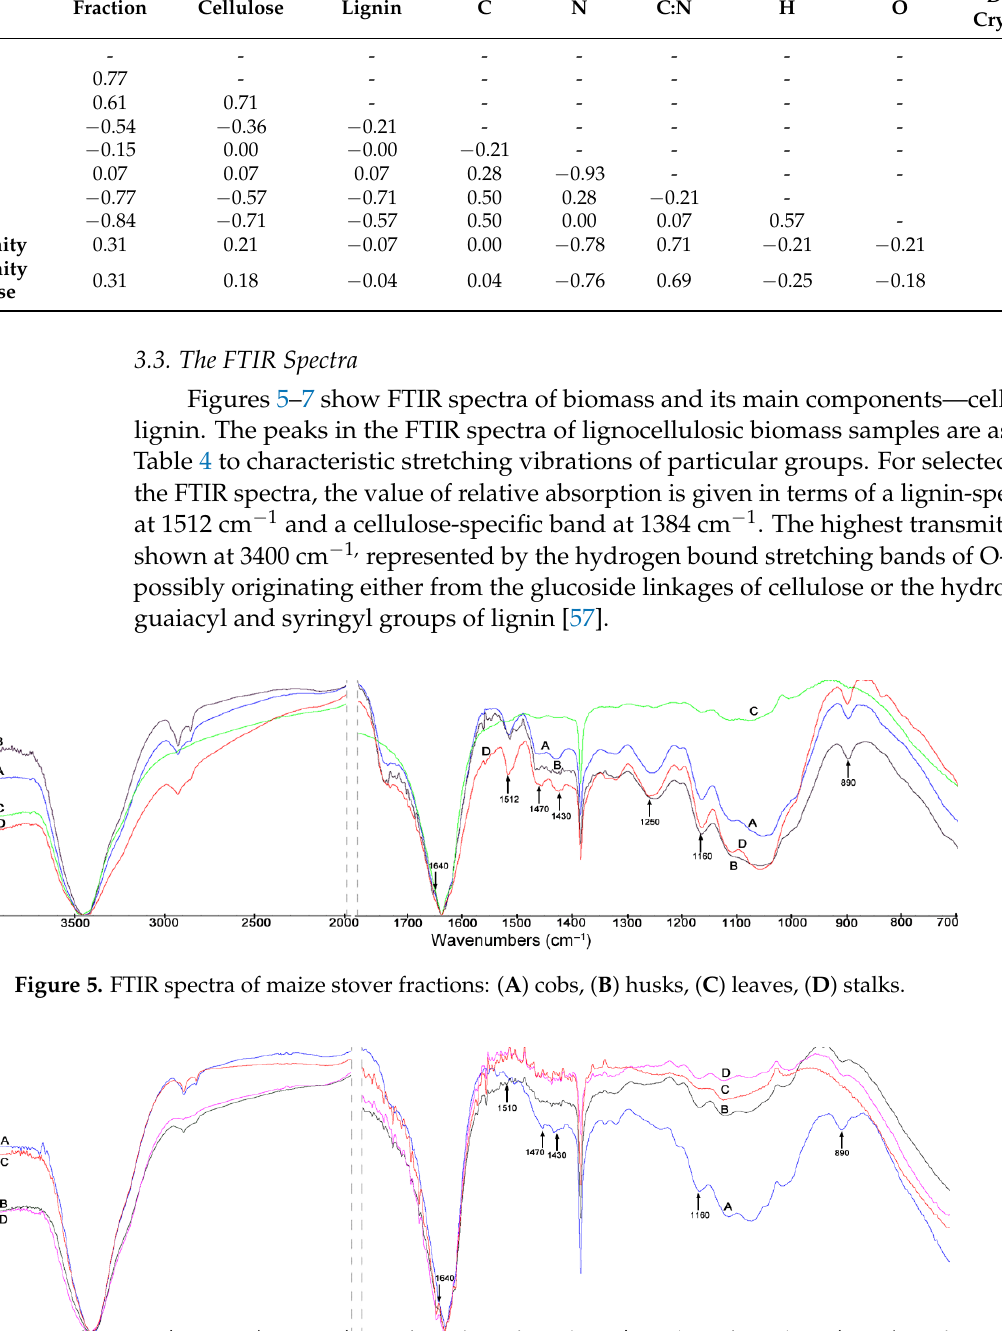
Table 3. Kendall’s τ coefficient between maize stover fractions, chemical composition and degree of crystallinity.